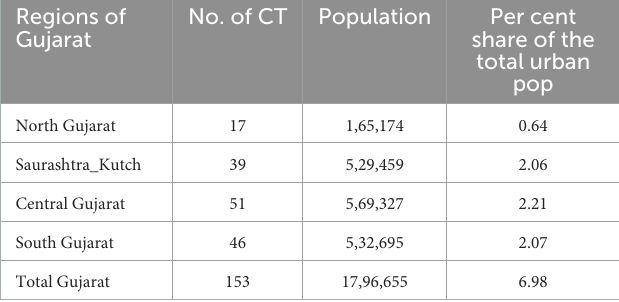
TABLE 10 Numbers and share of urban population in census towns of Gujarat, 2011. Regions of